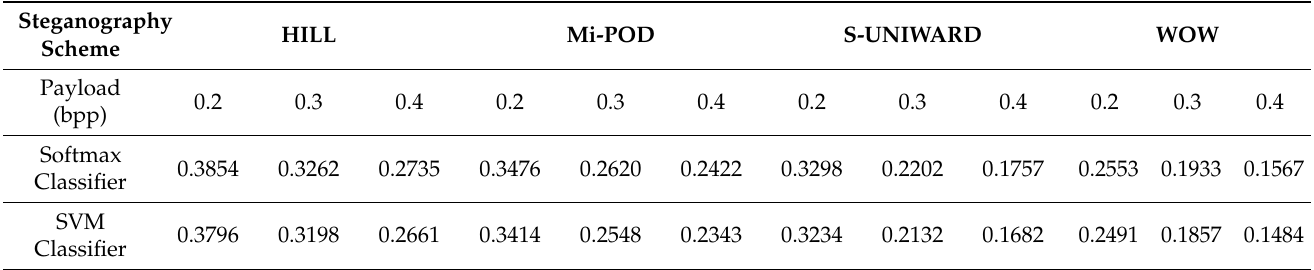
Table 5. Detection errors using softmax and SVM